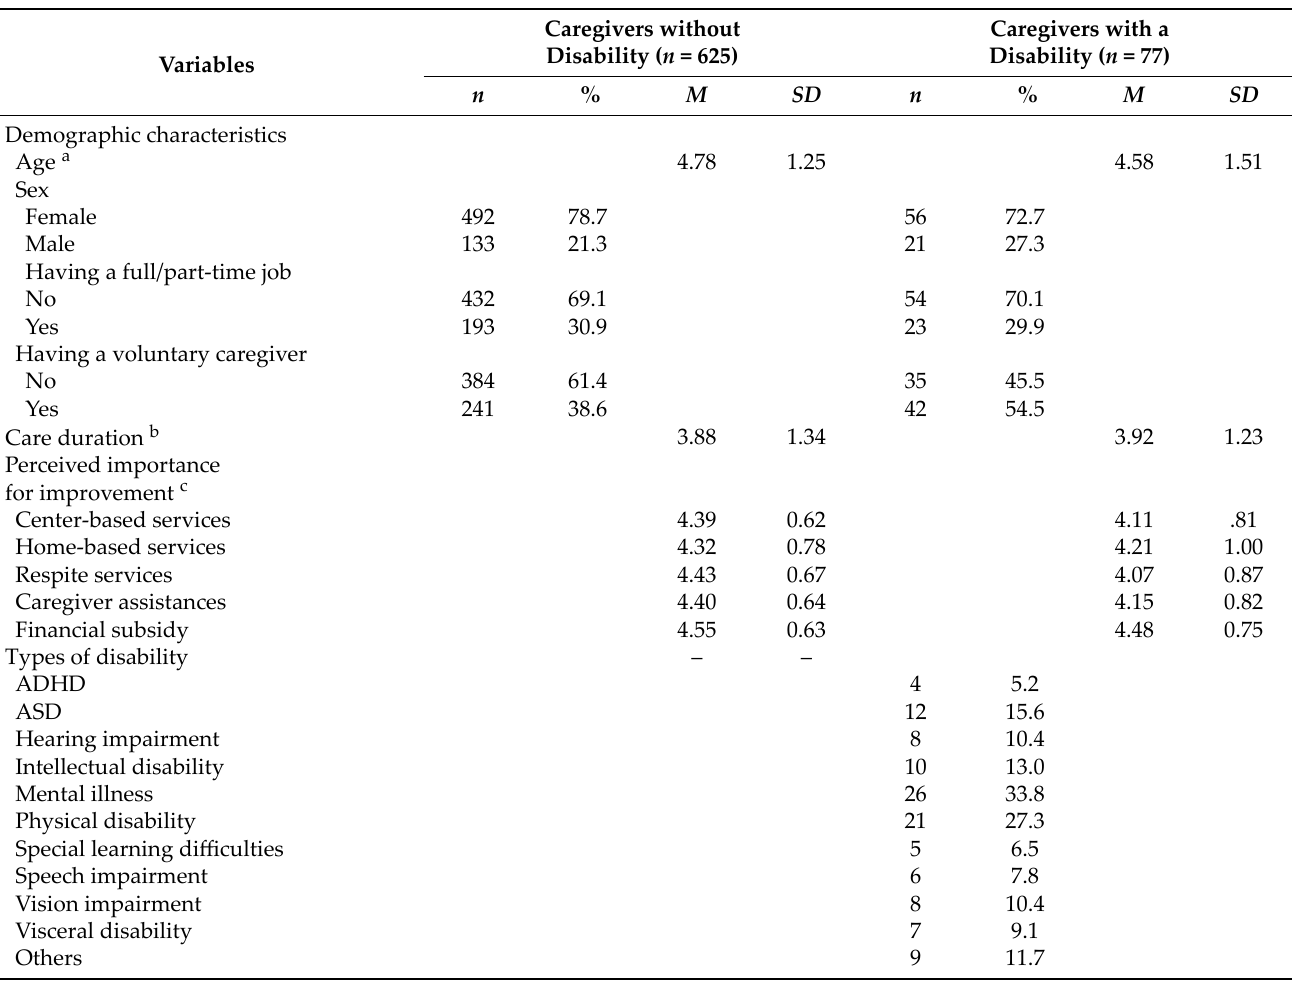
Table 1. Sample characteristics ( n =